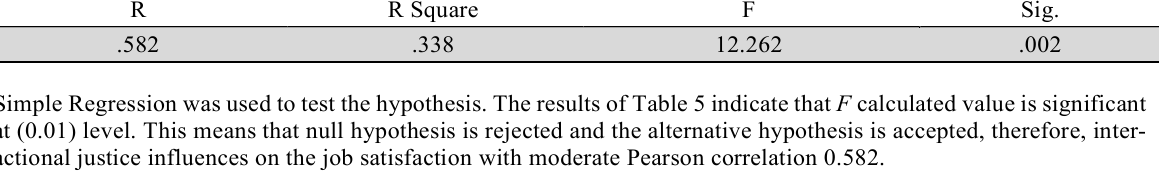
The results of testing the third sub-hypothesis R R Square F Sig. .582 .338 12.262